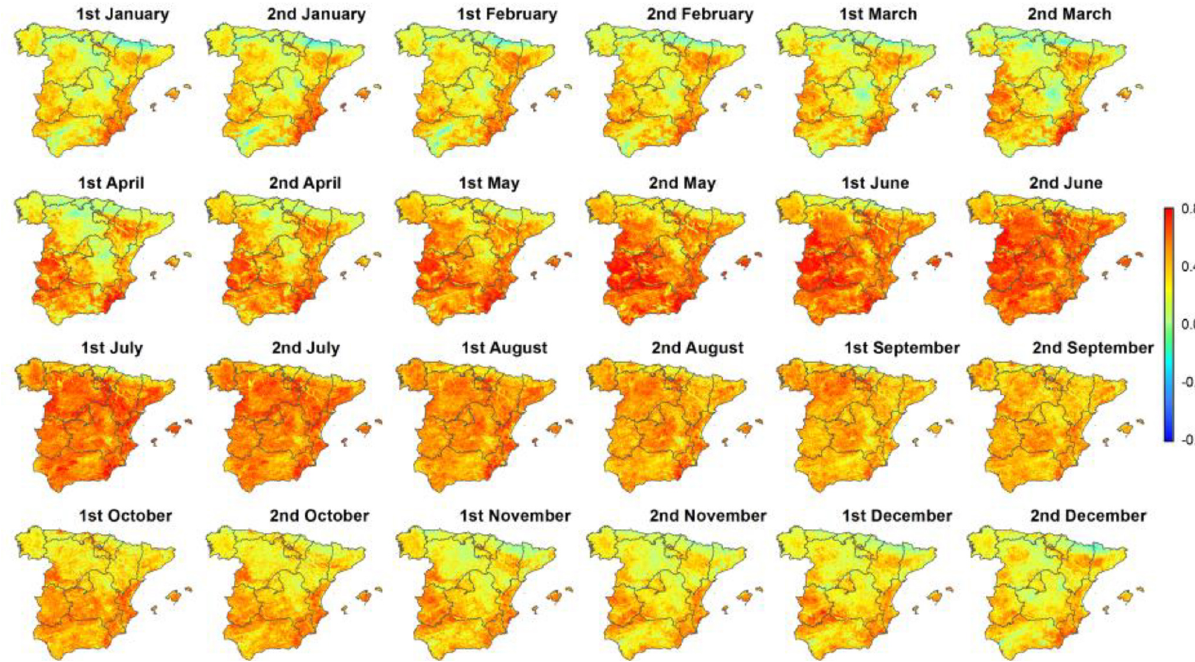
Figure 2. Spatial distribution of the maximum correlation between the sNDVI and the SPEI during the different semi-monthly periods.